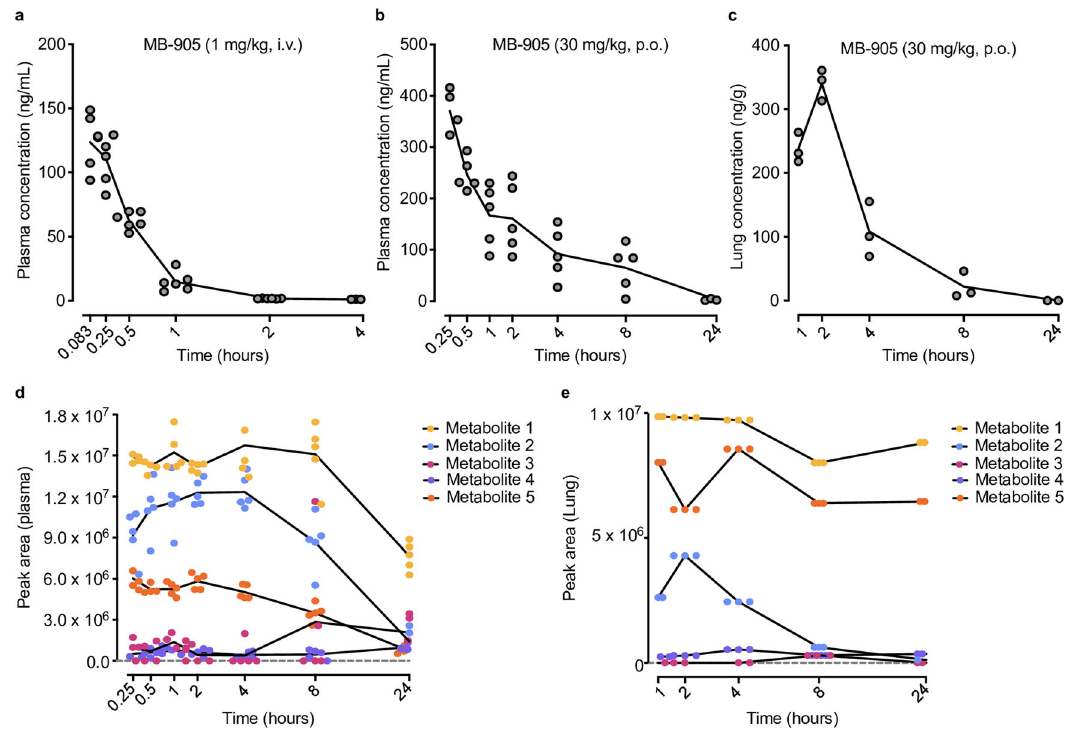
Fig. 4 | Pharmacokinetic and putative metabolites of MB-905 in rats. a Single intravenous dose (1mg/kg bodyweight)pharmacokineticsproperties of MB-905in rat plasma ( n =6); b single oral dose (30mg/kg bodyweight) pharmacokinetics properties of MB-905 in rat plasma ( n =5); c single oral dose (30mg/kg body- weight) pharmacokinetics properties of MB-905 in lung ( n =5); d plasma